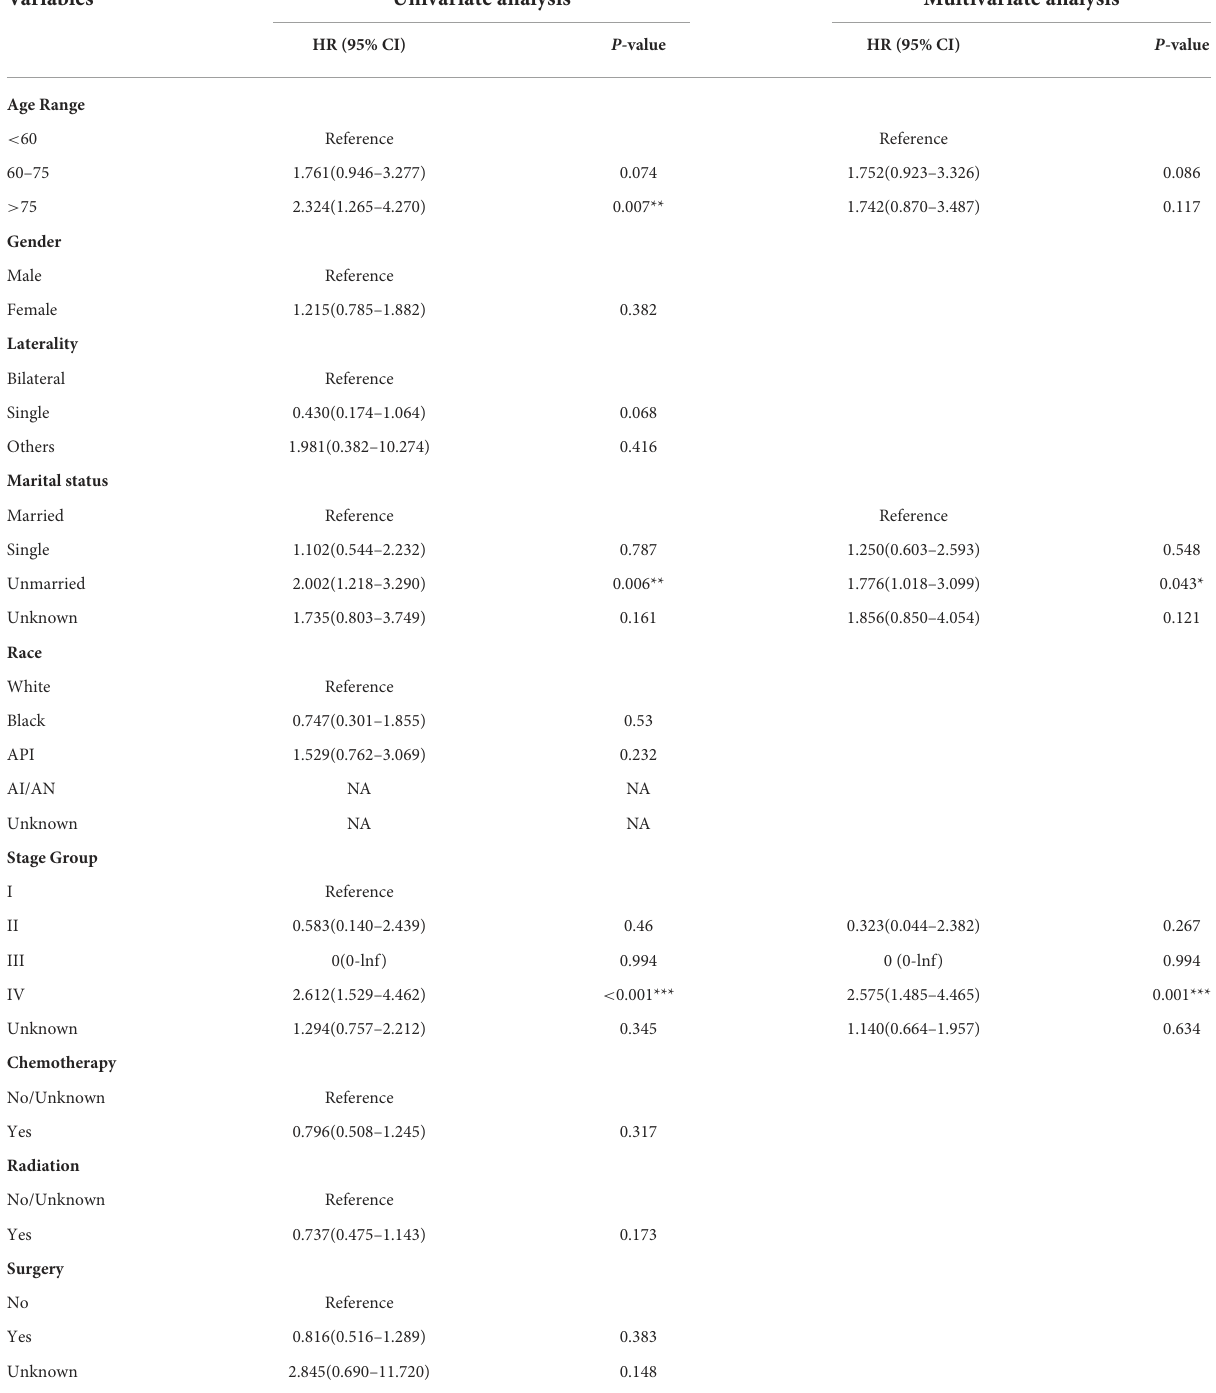
TABLE 4 Univariate and multivariate analysis of factors with the risk of CSS for orbital DLBCL patients identified in the SEER Program database from 2000 to 2017.